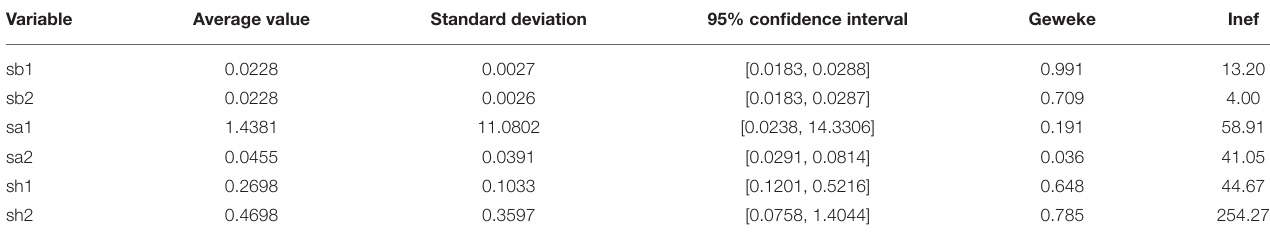
TABLE 3 | Parameter estimates of the price-based monetary policy